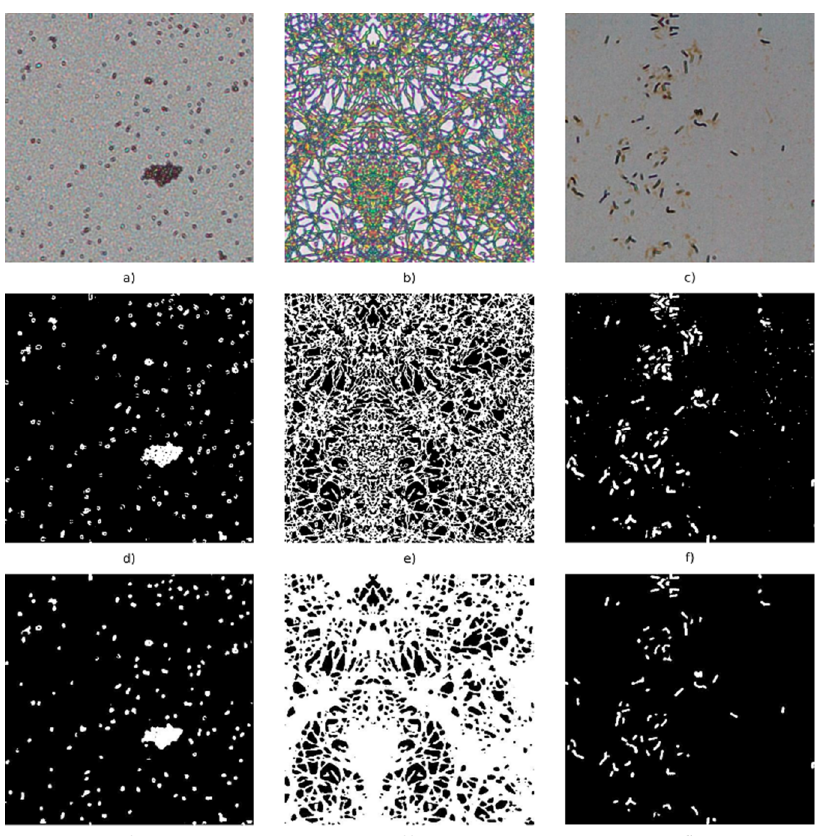
Figure 3. Localization of bacteria attachment and biofilm formation by N. sicca in experimental OM images. Acquired experimental images are shown in parts ( a – c ). The results of the application of a straightforward binary threshold operation are shown in parts ( d – f ). Finally, the results of the application of the fully convolutional neural network model are shown in parts ( g – i ).